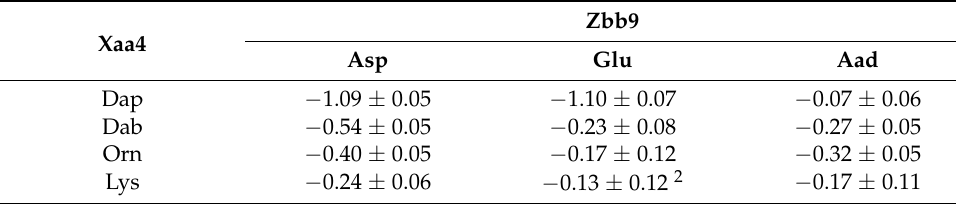
Table 3. The Xaa4-Zbb9 ion-pairing interaction energy ( ∆ G int , kcal/mol) 1